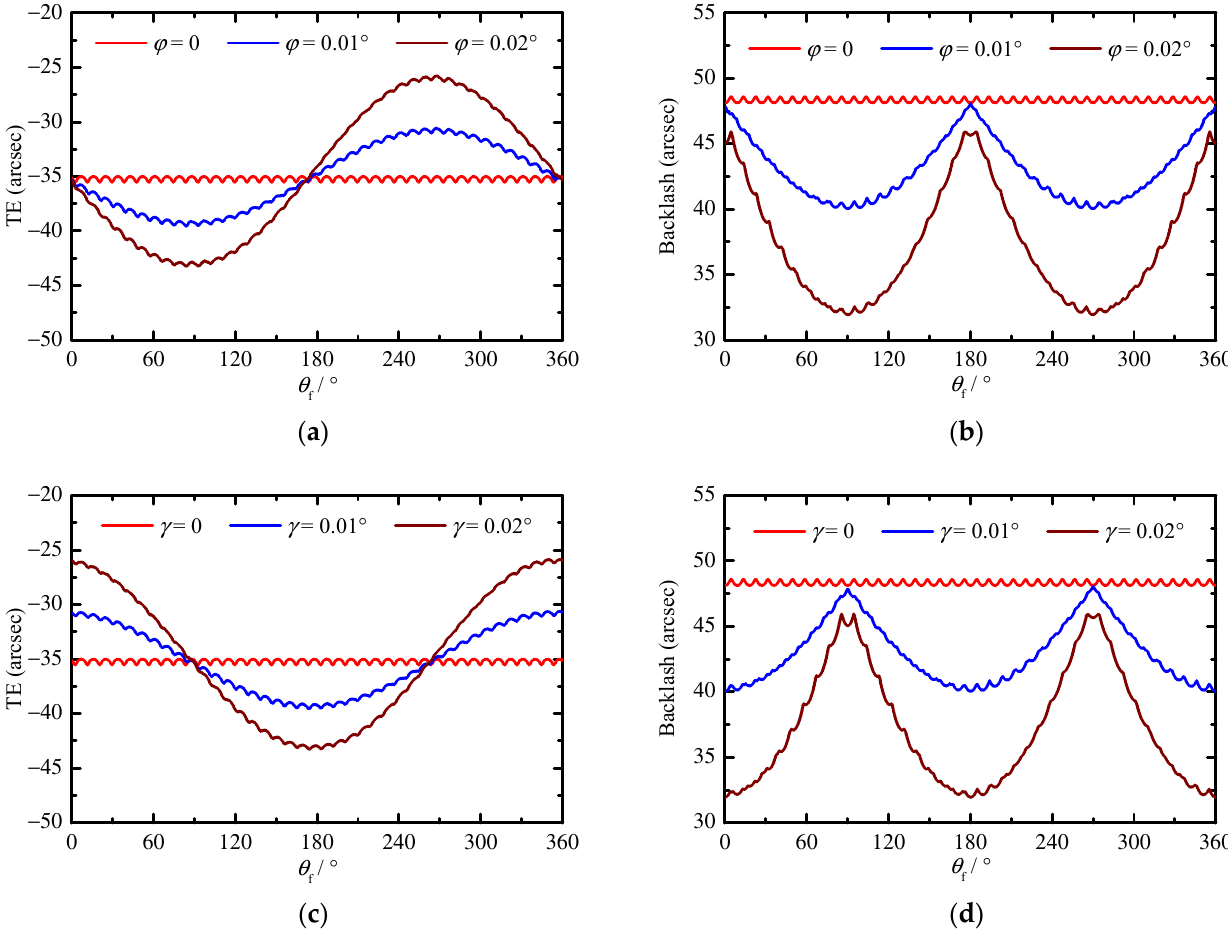
Figure 15. Results with misalignment deviations: ( a ) TE ( φ ), ( b ) backlash ( φ ), ( c ) TE ( γ ), and ( d ) backlash ( γ ).